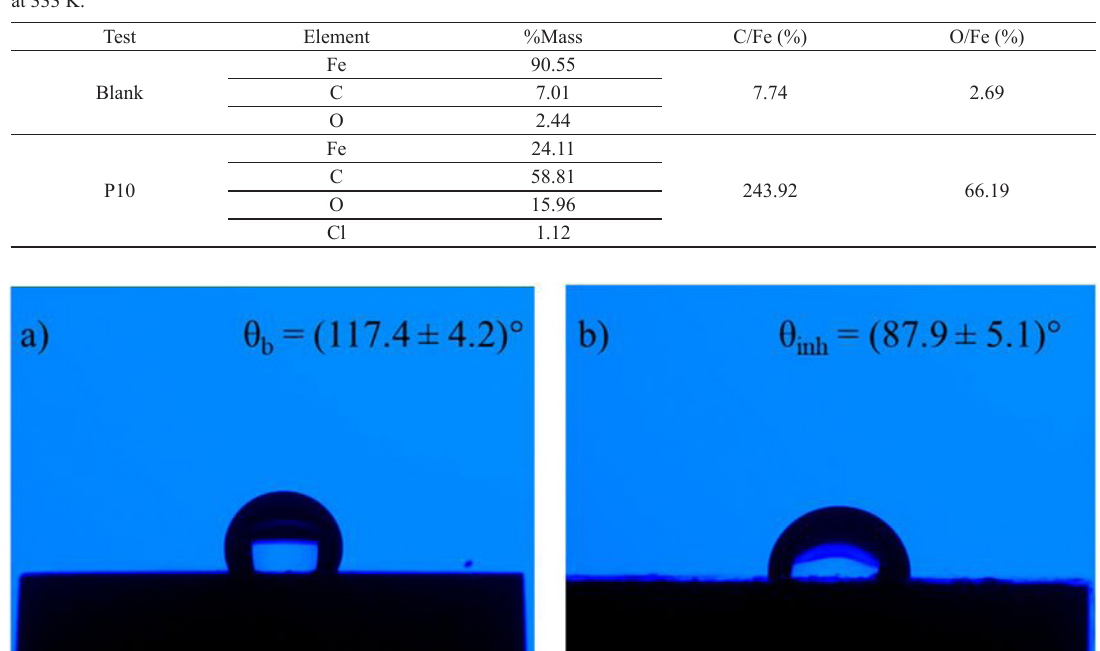
Figure 12. Contact angle images of API P110 carbon steel samples after 24 h of immersion in 1 M HCl at 333 K (a) without and (b) with the corrosion inhibitor (P10, 3.5%